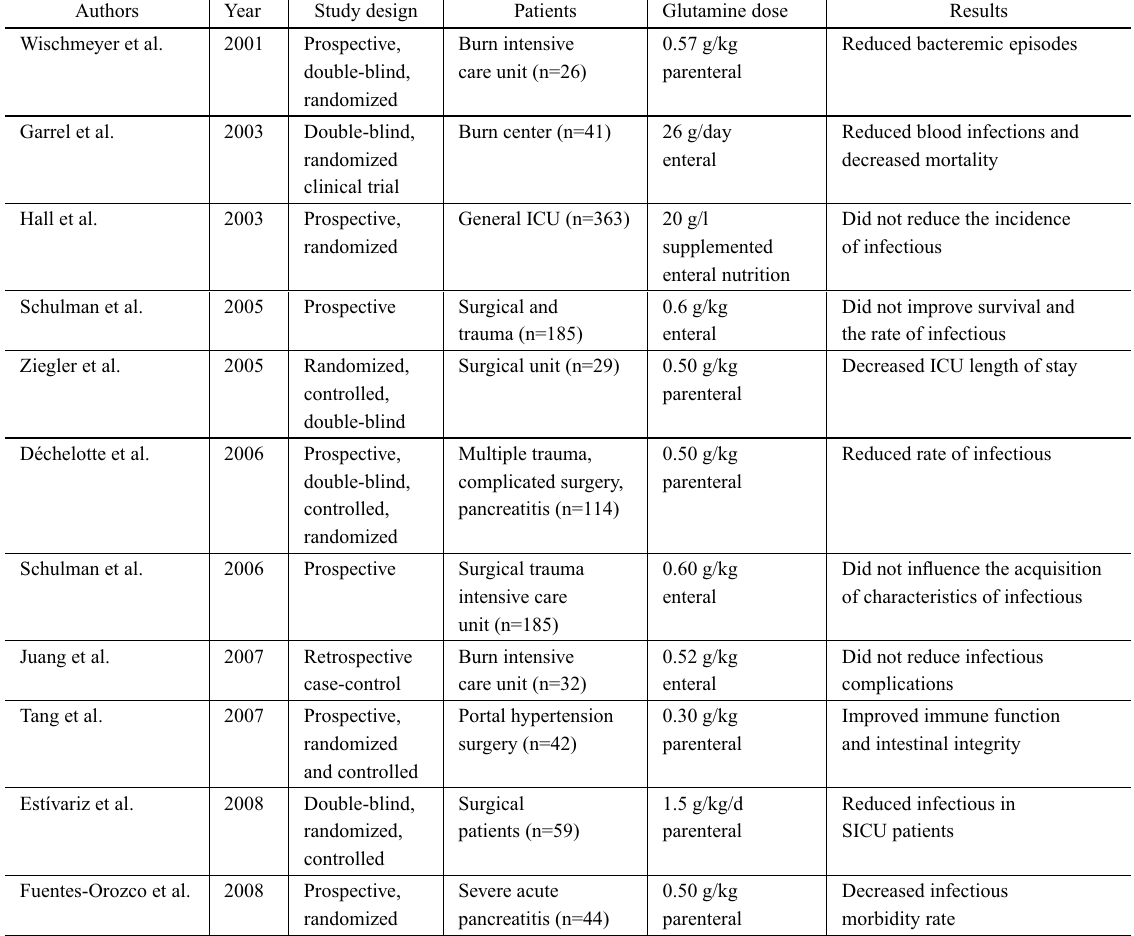
Effect of enteral and parenteral glutamine in critical